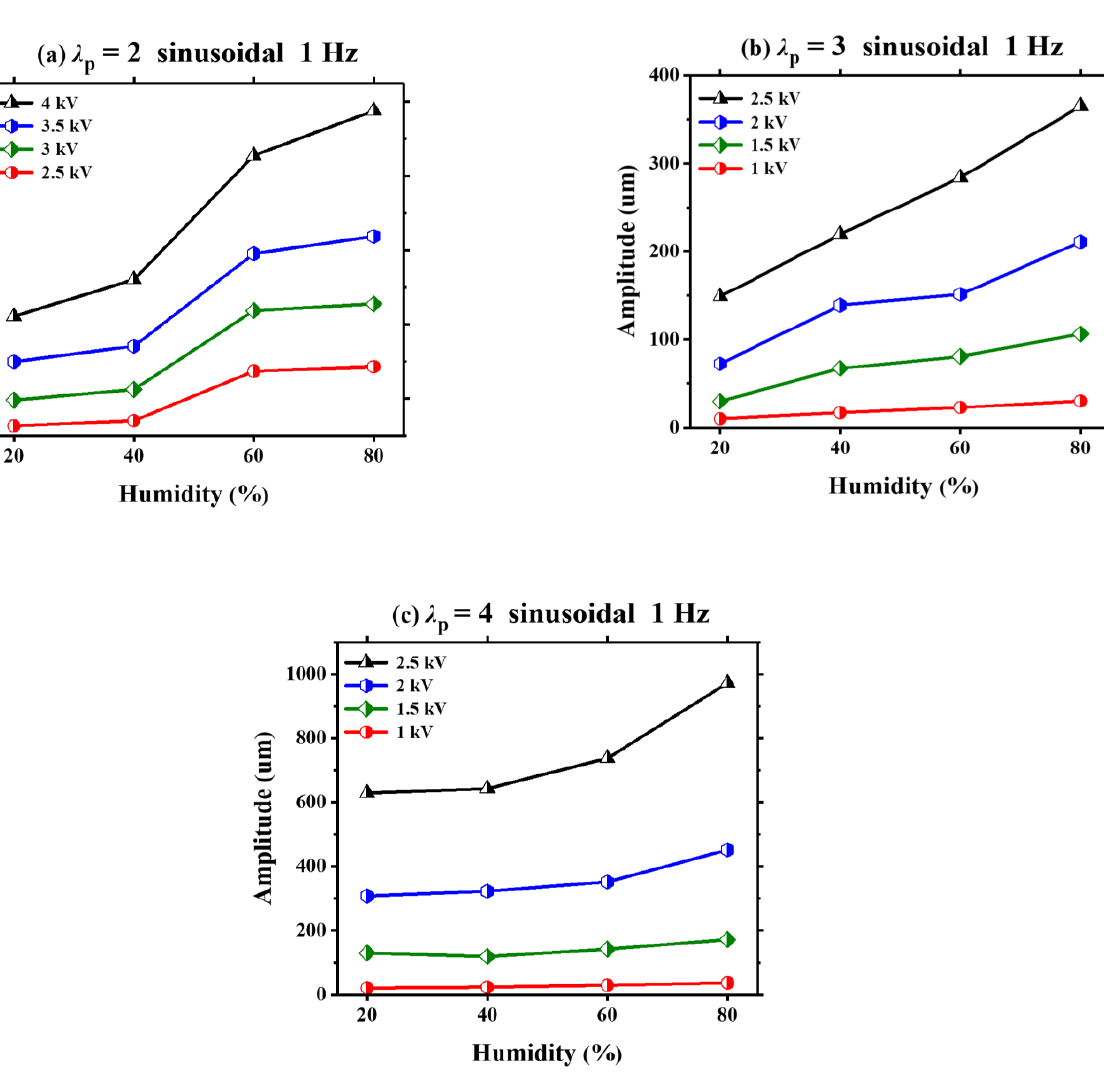
Figure 5. Under different pre-stretch ratios ( λ p = 2, λ p = 3 and λ p = 4), the humidity effect on the amplitude of VHB 4905 with different peak voltages.